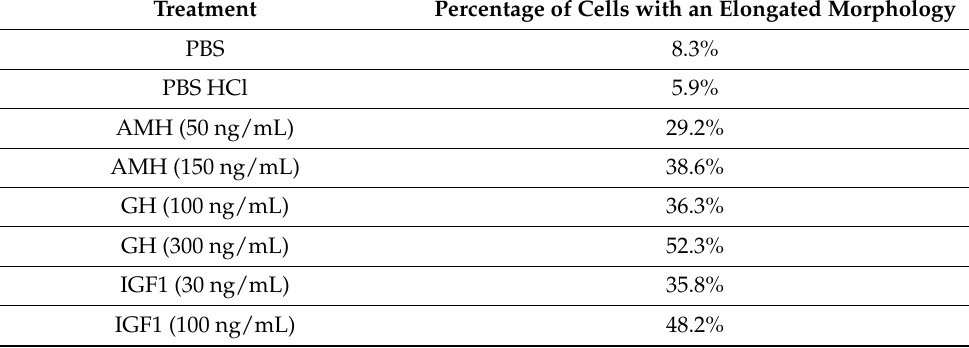
Table 1. Quantitation (%) of GN11 cells with an elongated morphology after treatment with AMH, GH, and IGF1. AMH, Anti-Müllerian hormone; GH, growth hormone; IGF1, insulin-like growth factor 1; PBS, phosphate buffer saline; HCl, hydrochloride. Treatment